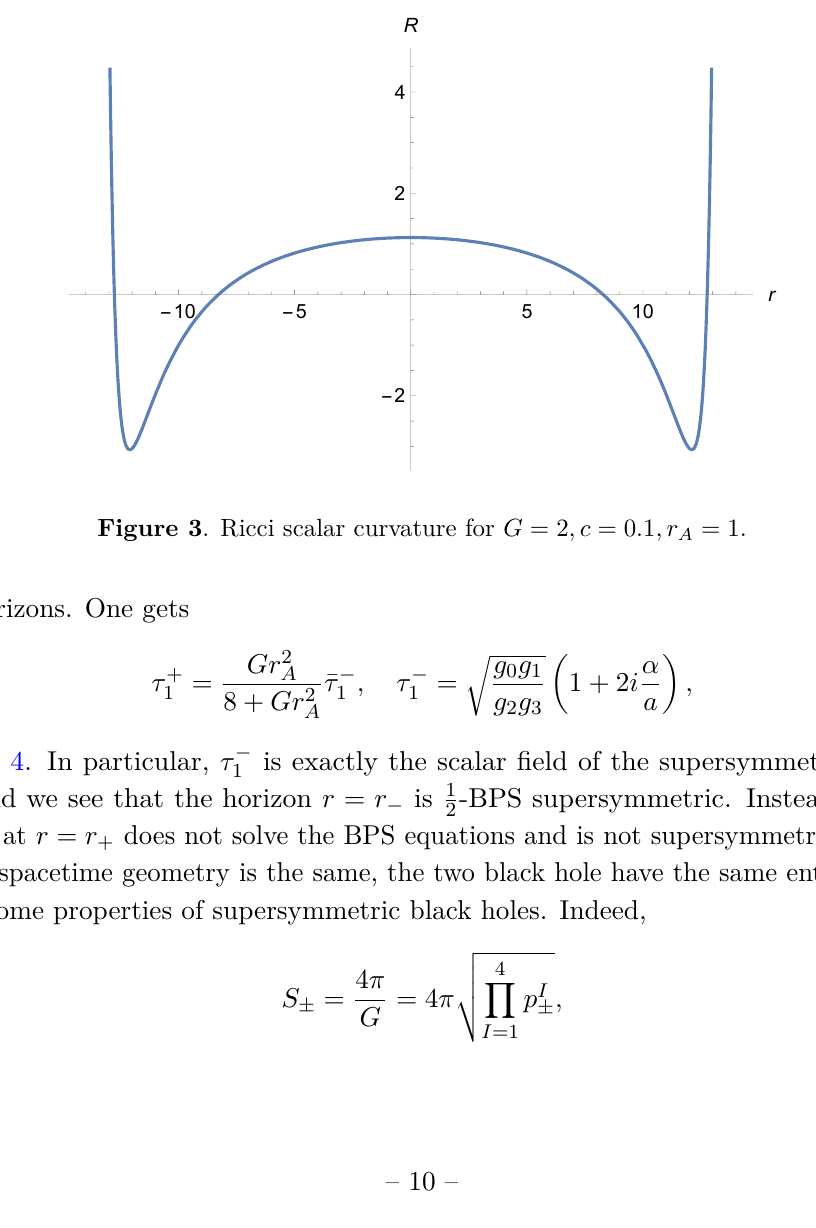
Figure 2 . Electric field interpreted as the t, r component of G I for G = 2 , c = 0 . 1 , r A = 1 , g 1 < 0 .